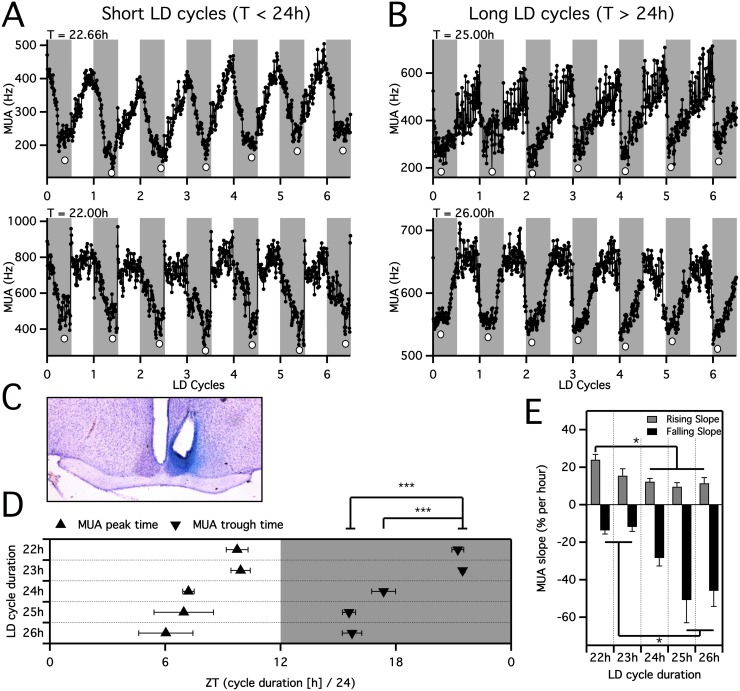
The waveform of SCN electrical activity is modulated by adaptation to short or long T-cycles.A. Raw electrical activity recordings from 2 individual animals adapted to short T-cycles (top: T = 22.66 h, bottom: T = 22 h, 10 minute time-resolution) over 6 cycles. Grey background indicates lights off. Round markers below the electrical activity trace indicate the timing of the trough. B. Recordings of SCN electrical activity during long T-cycles (top: T = 25 h, bottom: T = 26 h). Note the timing of the troughs at the beginning of the nights. C. Representative histological section confirming placement of electrode in the suprachiasmatic nucleus. D. The SCN electrical activity trough occurred late in the night during short T-cycles, near the middle of the night during T = 24 h and in the early night during long T-cycles. (***P<0.001). Peak SCN firing rates were near the end of the light period in T = 22 h and T = 23 h and near the middle of the light period in T = 24 h, T = 25 h and T = 26 h. E. Significant differences in the steepness of the declining and rising SCN electrical activity slopes (*P<0.05).